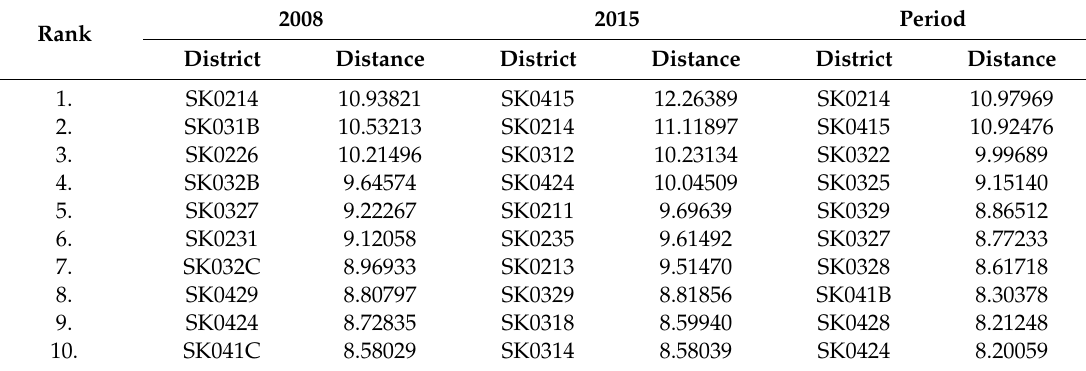
Table 3. The ten most extreme districts for the female sex preventable